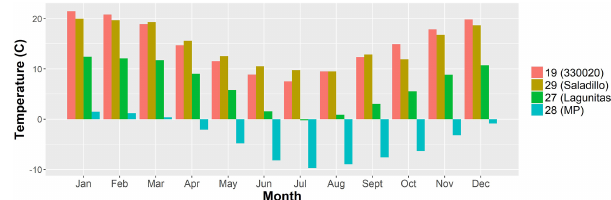
Figure 2. Monthly temperature averaged over the period of anal- ysis, September 2008–August 2013, for four of the gauges in the catchment. The numbers in the legend correspond to those in Fig. 1, while the text in parenthesis is the names of the gauges: 330020 (527ma.s.l.), Saladillo (1580ma.s.l.), Lagunitas (2765.5ma.s.l.) and MP